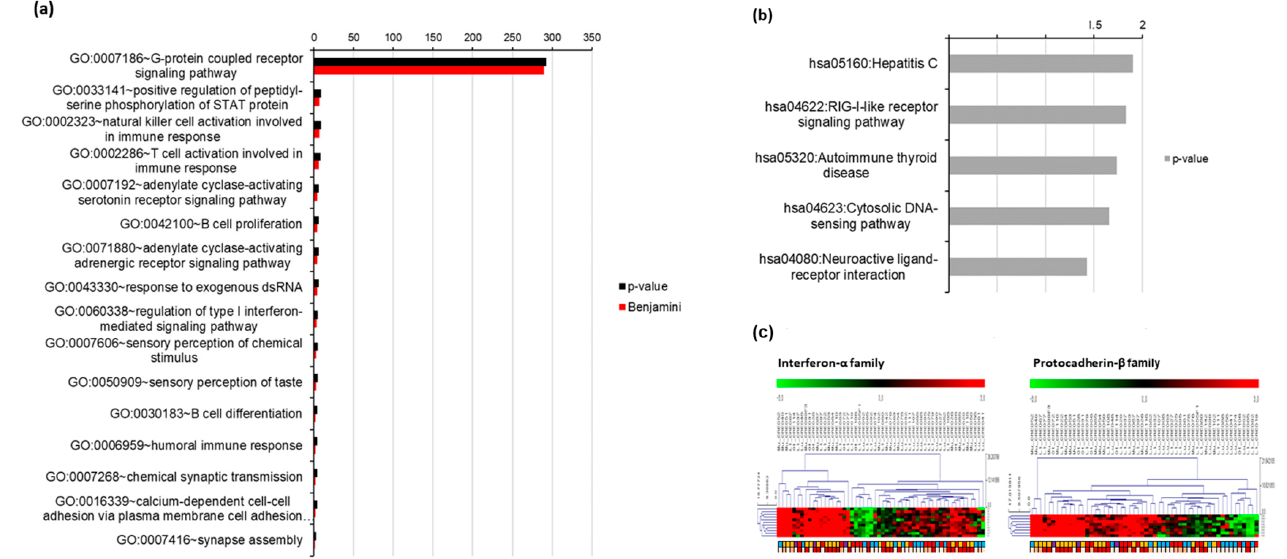
Figure 4. Gene ontology (GO) of exosomal RNA in mCRC patients: ( a ) biologic process, ( b ) KEGG pathway and ( c ) common enriched gene sets. Abbreviations: mCRC, metastatic colorectal cancer; and KEGG, Kyoto Encyclopedia of Genes and Genomes.